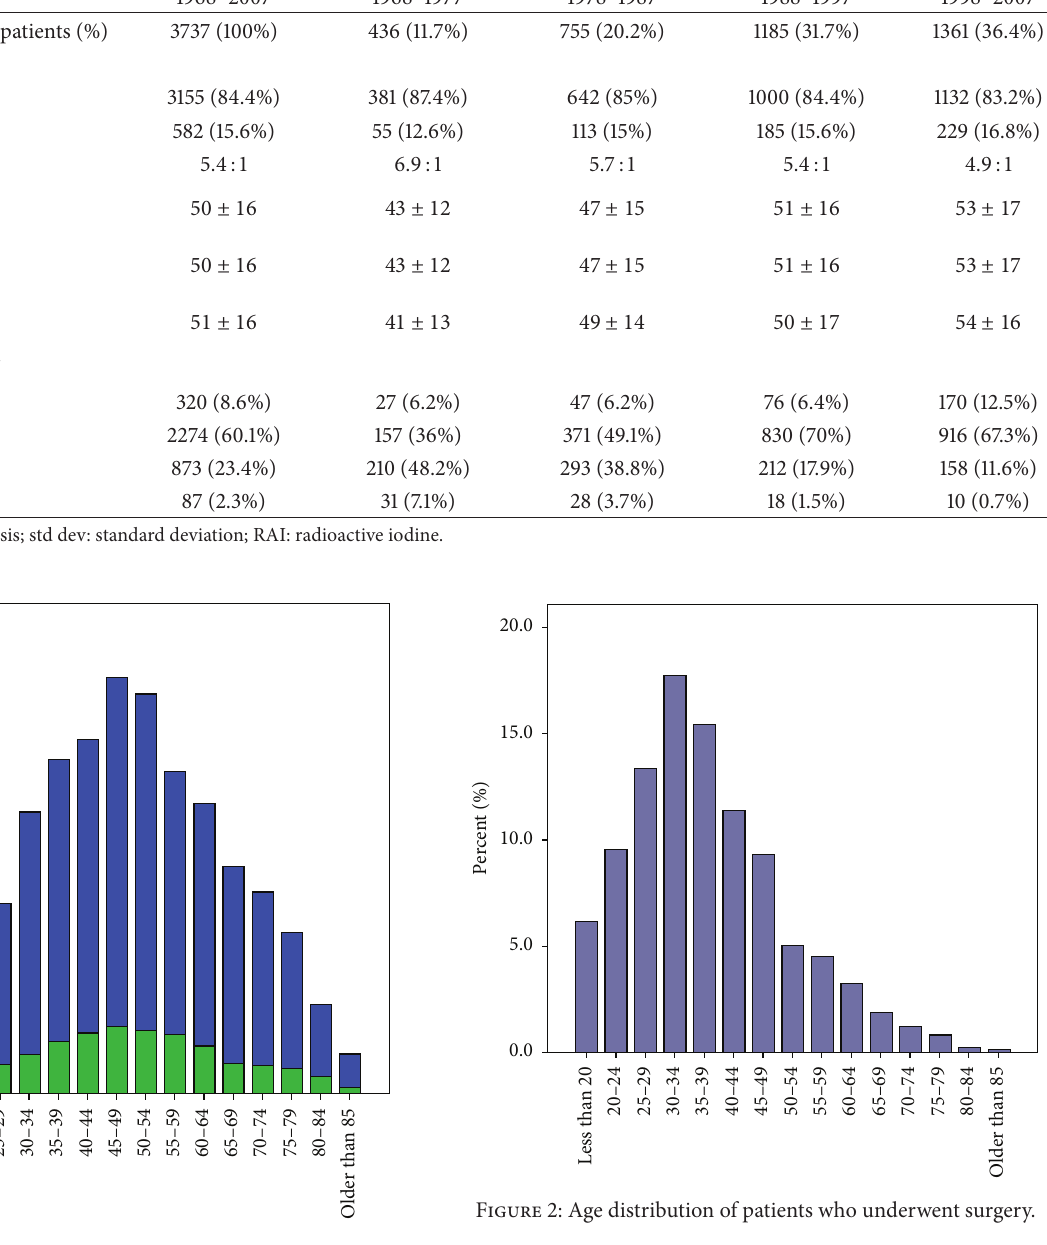
or total thyroidectomy. There was a downward trend in the recurrence rates after surgical treatment (11.4% versus 3%: Group A versus Group D) over the decades and this trend is likely to reflect the change in surgical practice from subtotal thyroidectomy to total thyroidectomy (Table 2). The mean time from surgical treatment to recurrence was 127 ± 91 months (range: 4–338 months). On the other hand, the rate of postoperative hypothyroidism increased from 75% (Groups A and B) to 96.4% (Groups C and D) reflecting the use of total thyroidectomy as the preferred surgical